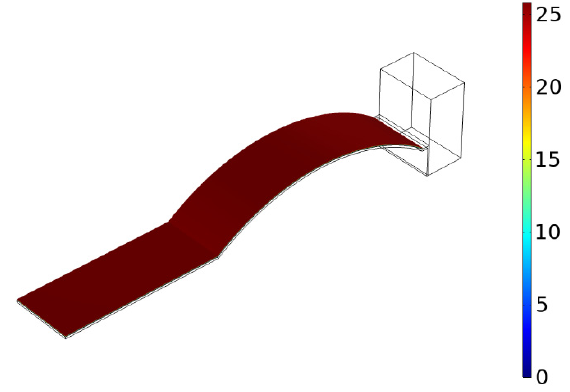
Figure 11. Voltage Figure 11. Voltage cloud.